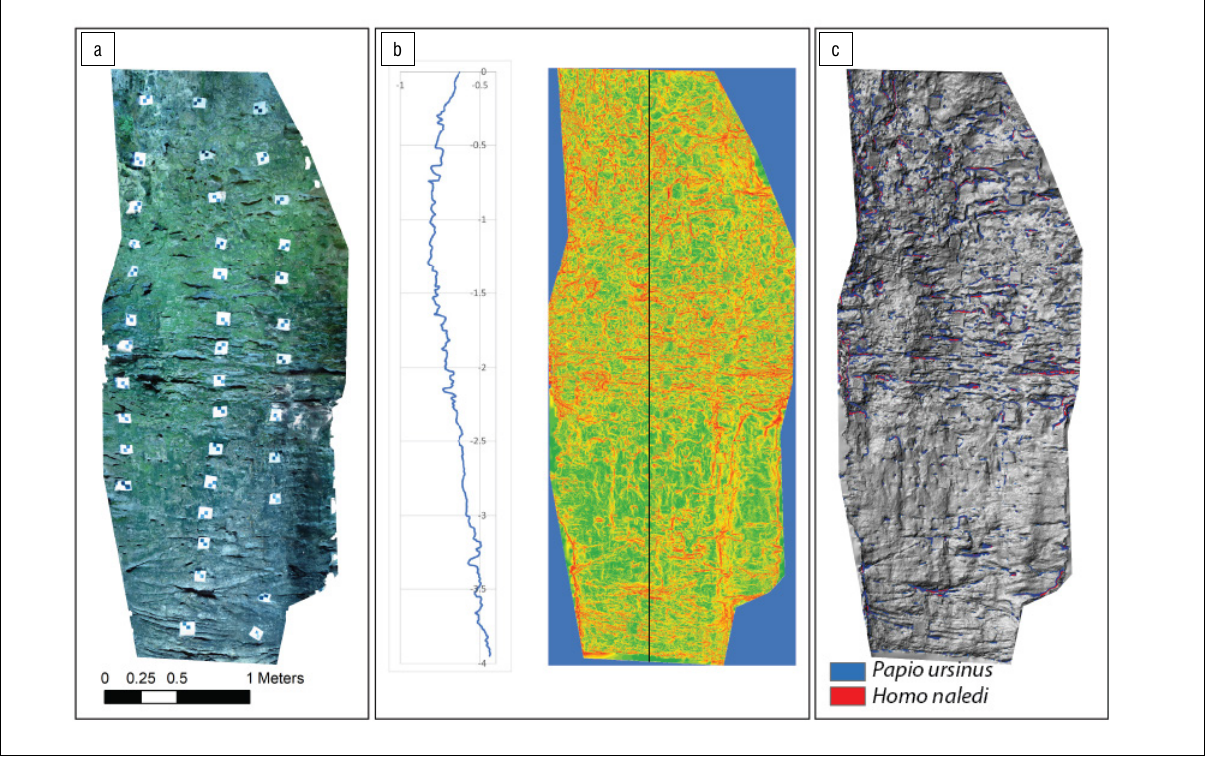
Figure 5: Section of vertical rock wall at the entrance to Dronkvlei Cave, South Africa. It is a surface that baboons climb regularly (Figure 4b) and the focus of our analysis. (a) Composite orthophoto and ground control points. (b) Digital elevation model to visualise the rugosity and verticality of the surface (the cross-sectional profile on the left corresponds to the black line). Red surfaces slope outward, whereas green surfaces are relatively flat. (c) Hillshaded visualisation; the colours correspond to handholds that are likely to compel weight-bearing finger flexion by chacma baboons ( Papio ursinus ) and Homo naledi . The 3D mesh and raw photo are available in MorphoSource (https://www.morphosource.org/